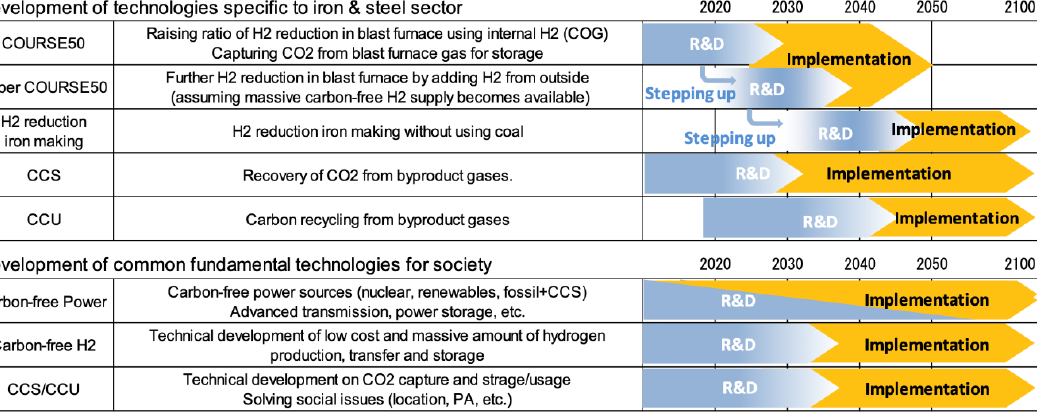
Figure 28. Long-term vision of the Japanese iron and steel industry for zero-carbon steelmaking [66].